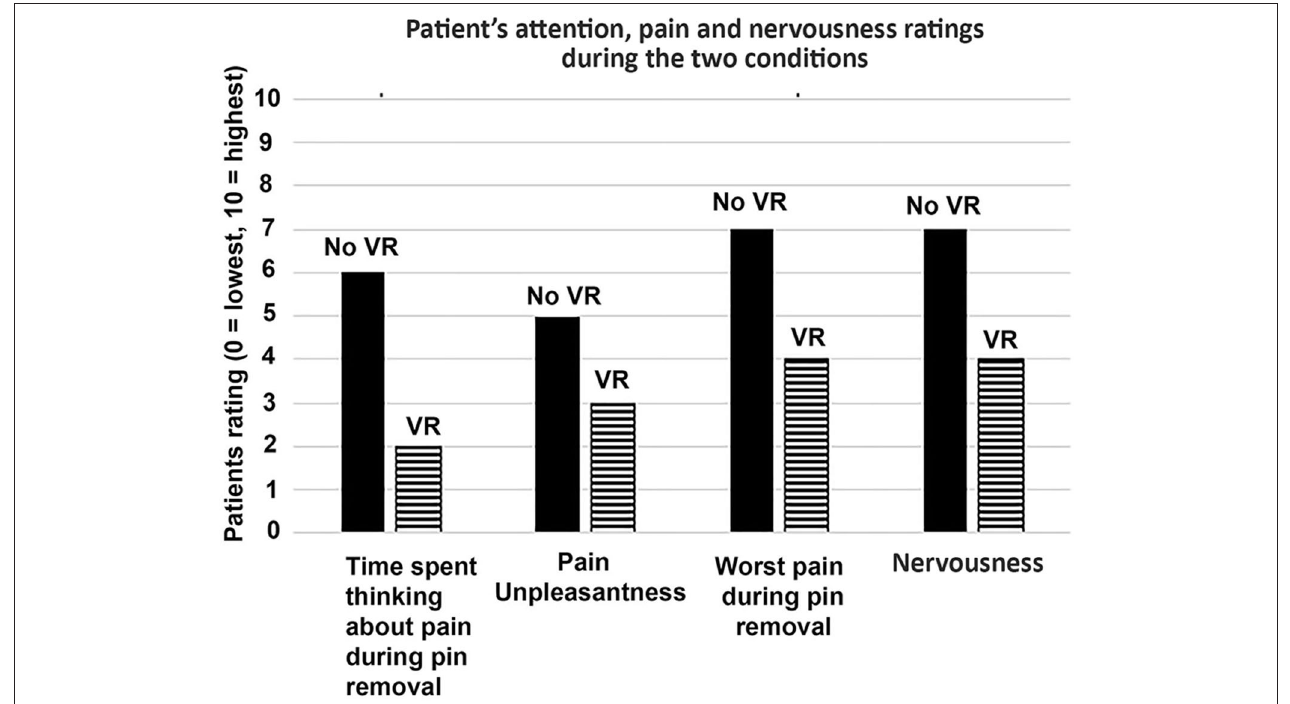
FIGURE 2 | Patient rated their pain during one pin removal with VR, vs. another pin removal during No VR.